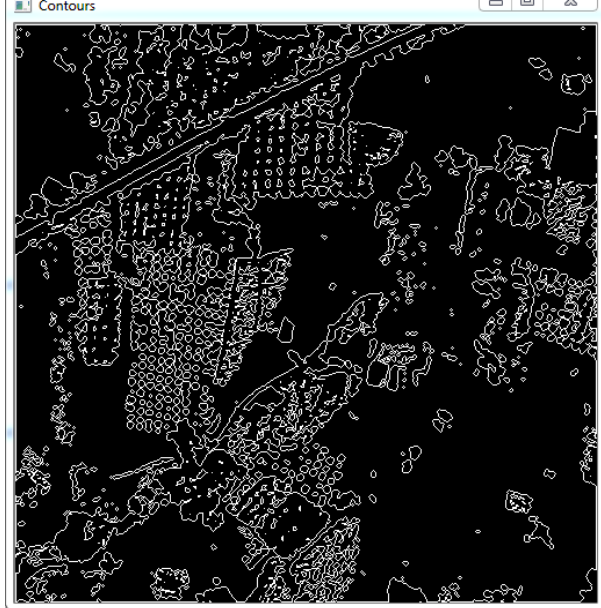
Figure 7. Delineation of